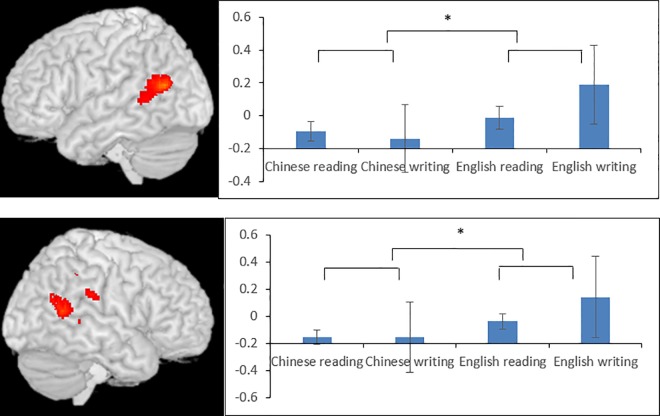
ROI analysis at the bilateral superior temporal gyri in the Chinese L1 group.The center is at (-58, -66, 16) for the left STG and at (62, -56, 12) for the right STG. Chinese L1 participants showed greater activation for English than for Chinese at these two regions. * indicates significance at p < .1. Error bars indicate standard errors.